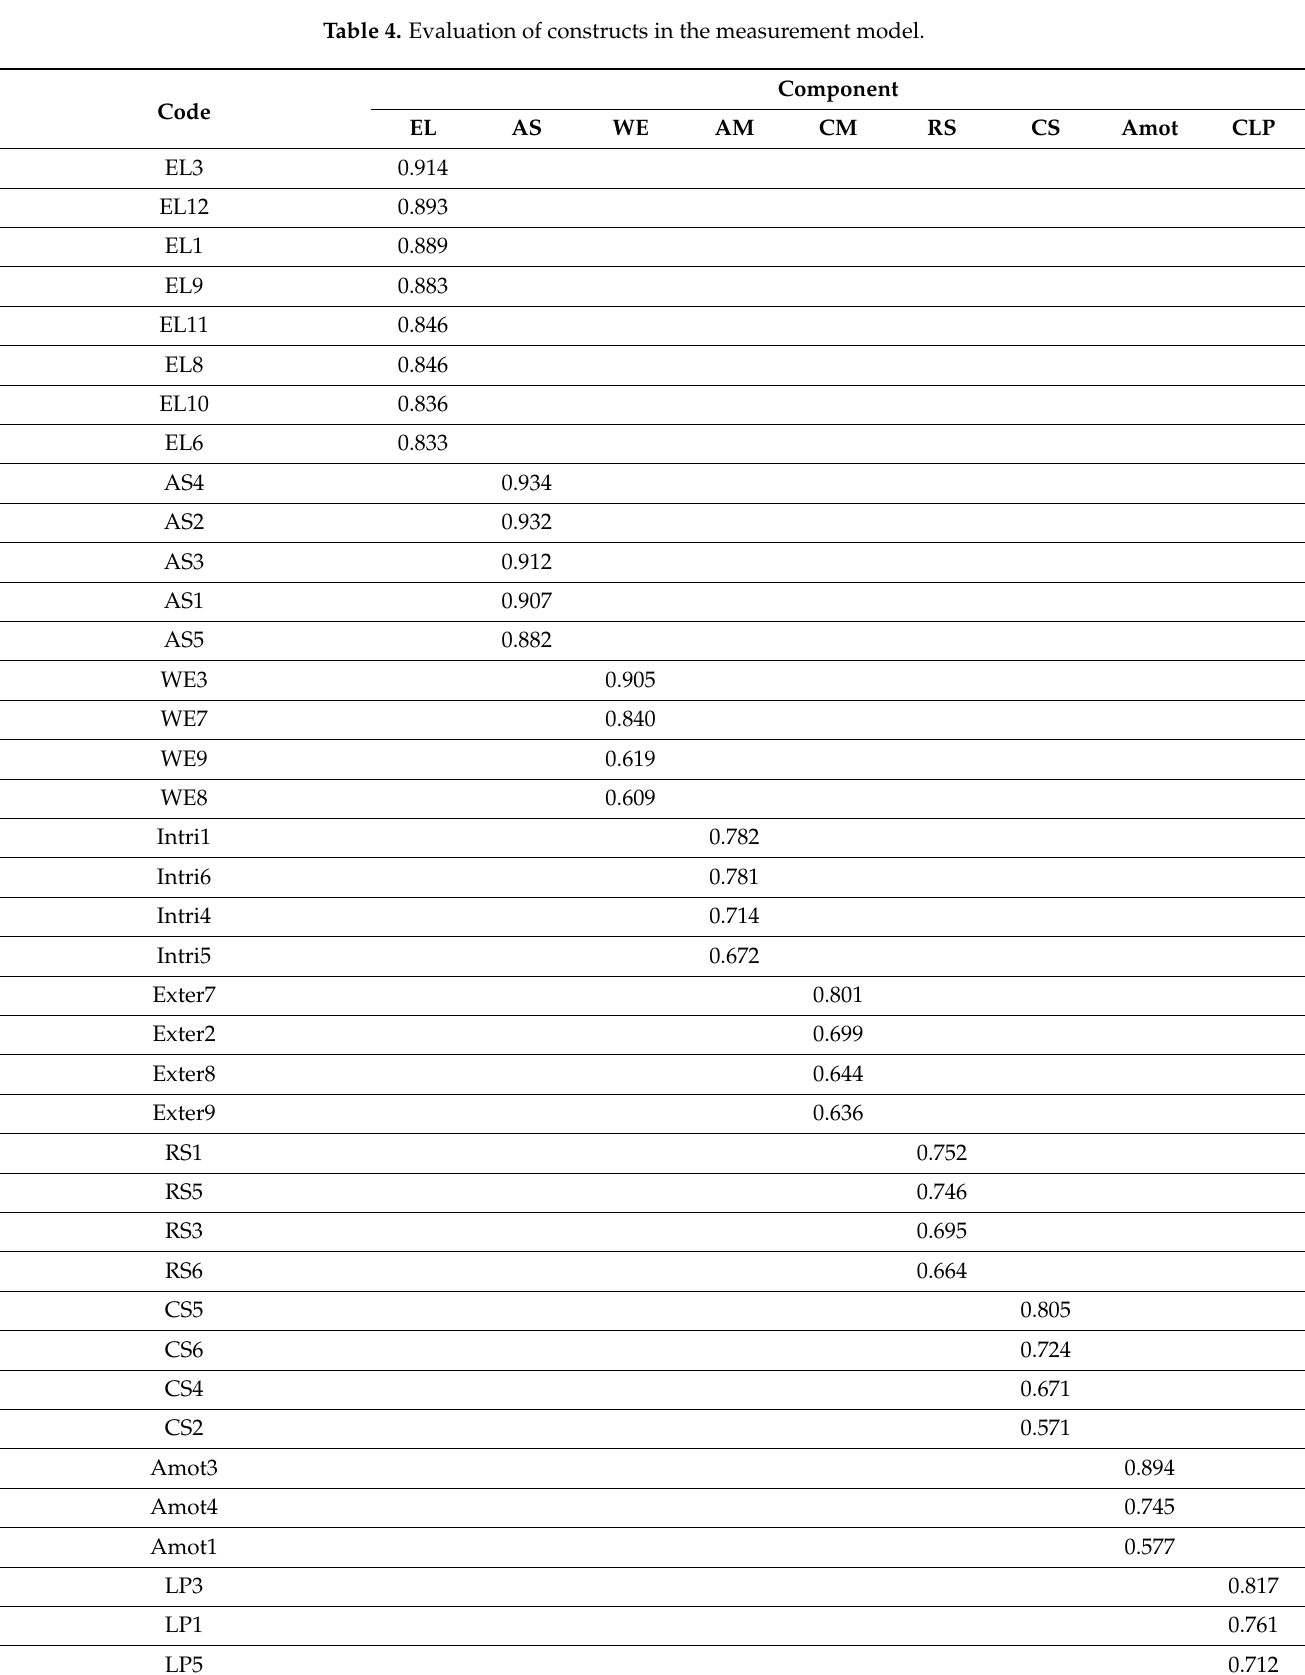
Table 4. Evaluation of constructs in the measurement